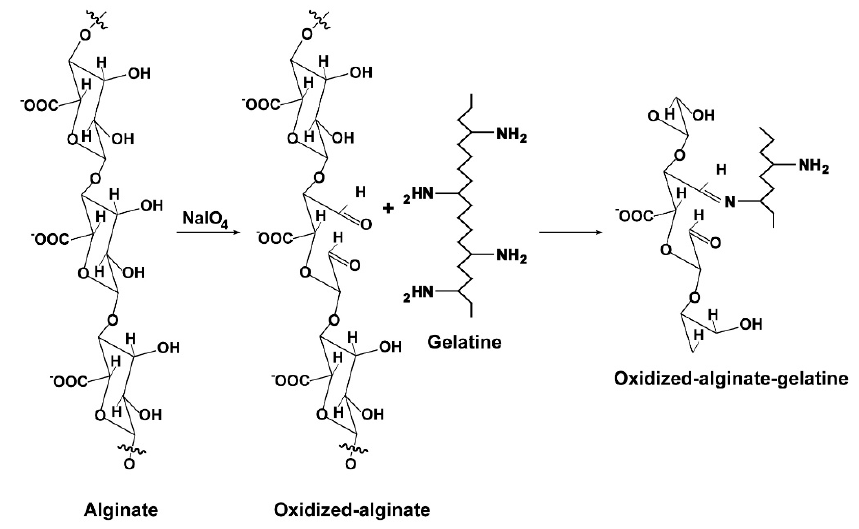
Figure 1. Oxidation of sodium alginate by periodate (NaIO 4 ) and cross-linking with gelatine.